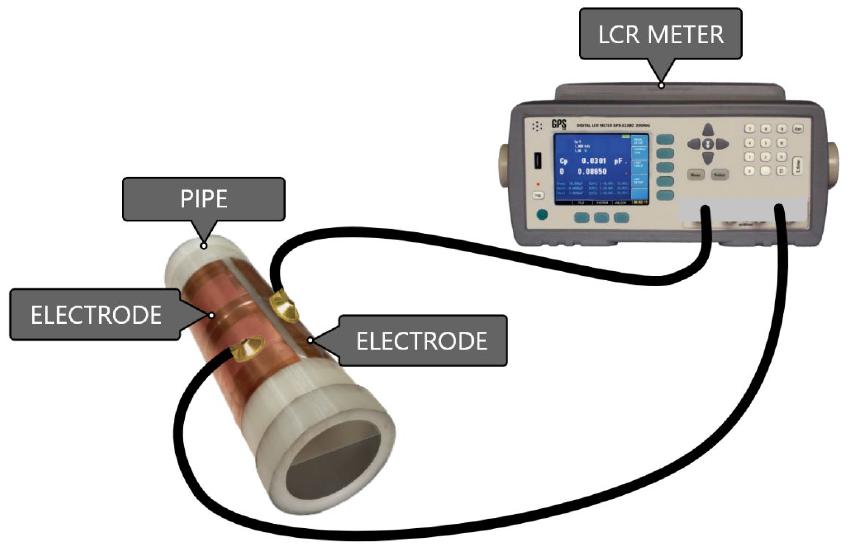
Figure 3. Measuring the capacitance value of pipe with a horizontal concave sensor using an LCR meter. Table 1. Measured capacity values in different void fractions for double ring sensor.